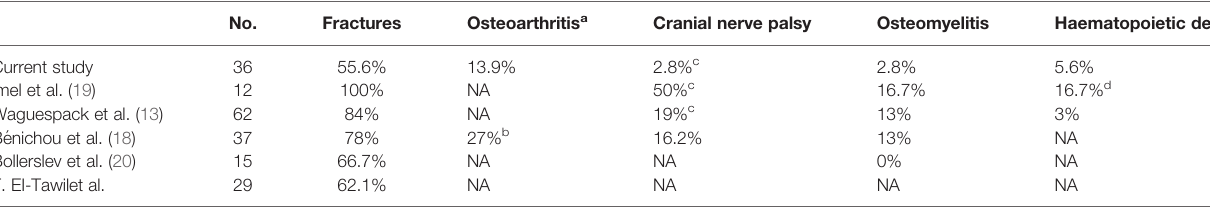
TABLE 9 | Clinical characteristics of patients with ADO II: a comparison of